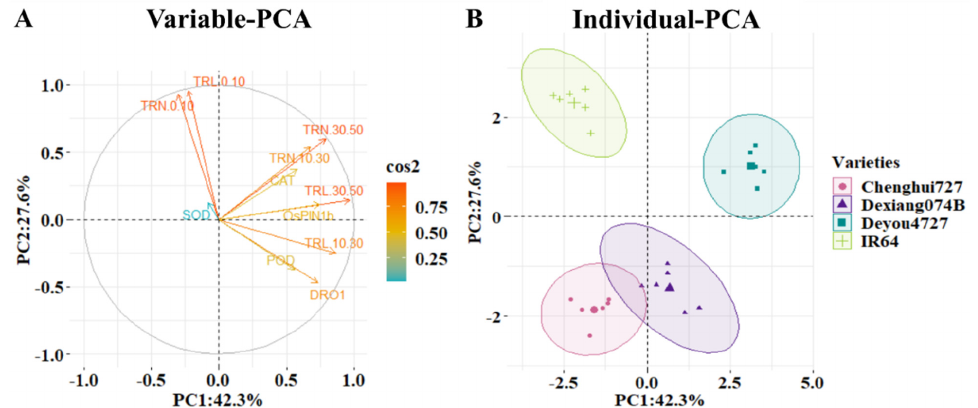
Figure 6. The multivariate principal component analysis (PCA) for IR64, Chenghui727, Dexiang074B, and Deyou4727 considering root traits, responsible genes, and enzymatic systems. TRN = the total number of roots at the top (0–10 cm), middle (10–30 cm), and bottom (30–50 cm); TRL = the total root length at the top (0–10 cm), middle (10–30 cm), and bottom (30–50 cm), and the activity of CAT, SOD, POD, and the expression of the OsPIN1b and DRO1 genes. ( A ). The loading plot of the physiological and biochemical variables for the first (PC1) and second (PC2) principal components for variables. ( B ) Sample score of the individuals for IR64, Chenghui727, Dexiang074B, and Deyou4727. The correlation coefficient for irrigation and drought for plant traits and grain yield (GY) under irrigation and drought were measured (Figure 7). Under irrigation conditions, TRN-M (r = 0.8), TRN-B (r = 0.9), SN (r = 1), TRL-M (r = 0.9), TRL-B (r = 0.9), and POD-L (r = 0.9) showed significant ( p < 0.05) positive correlation. Similarly, under drought condi- tions, SN (r = 1), TRN-M (r = 0.9), TRN-B (r = 0.9), TRL-M (r = 1), TRL-B (r = 1), CAT-L (r = 0.8), SOD-L (r = 1), POD-L (r = 1), and CAT-R (r = 1) showed significant ( p < 0.05) positive correlation. The oxidative enzymes POD, SOD, and CAT are important under drought stress; these indicate that versatile enzymatic system helped plants to survive drought conditions and increase yields.